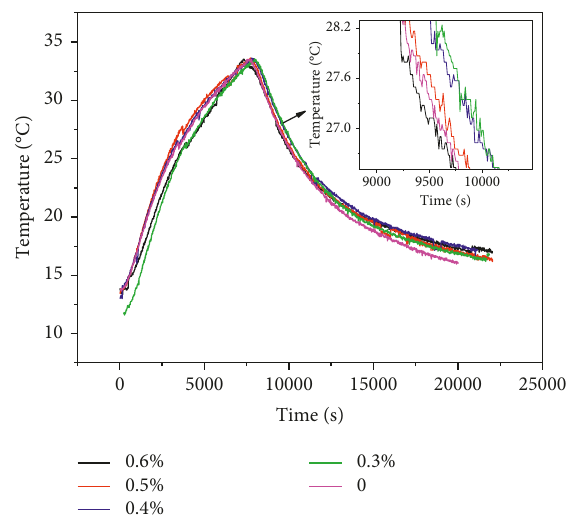
Figure 10: The center of the cubicle system temperature variation